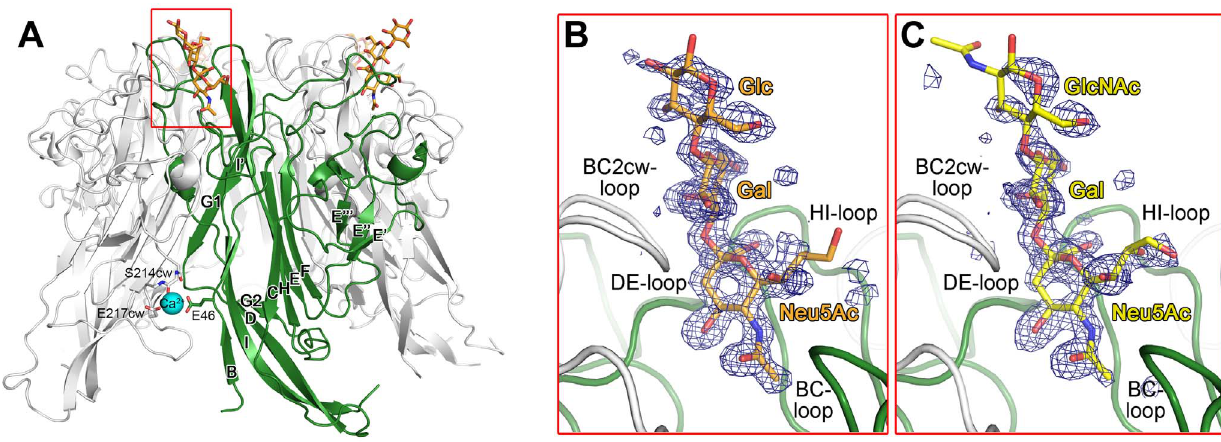
Figure 2. Structure an LPyV VP1 carbohydrate receptor complex. A. Overview of the LPyV VP1 structure in complex with 3SL. A LPyV VP1 pentamer is shown in cartoon representation, with one monomer highlighted in green. The oligosaccharide ligand is drawn in stick representation and colored by element, with carbons in orange, nitrogens in blue and oxygens in red. The calcium ion bound to the free LPyV VP1 pentamer is shown as a cyan sphere, with LPyV residues contacting it shown in stick representation. Residues 28–38 at the N-terminus are involved in non-native crystal contacts and are not shown here for clarity. B. and C. Close-up views of the 3SL (B) and 3SLN (C) binding sites. LPyV VP1 is drawn as in (A). The oligosaccharides are shown in stick representation, with 3SL in orange and 3SLN in yellow. Composite annealed omit difference density maps are shown contoured at 2.5 s with a radius of 3.5 A˚ around the respective oligosaccharides.